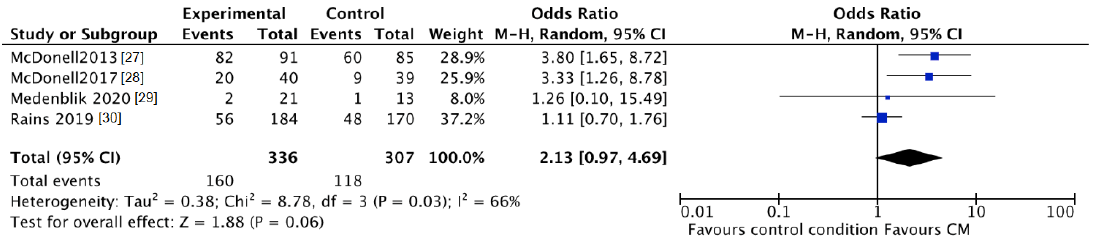
Figure 4. Forest plot of the comparison CM versus standard care after intervention, percentage of participants with negative